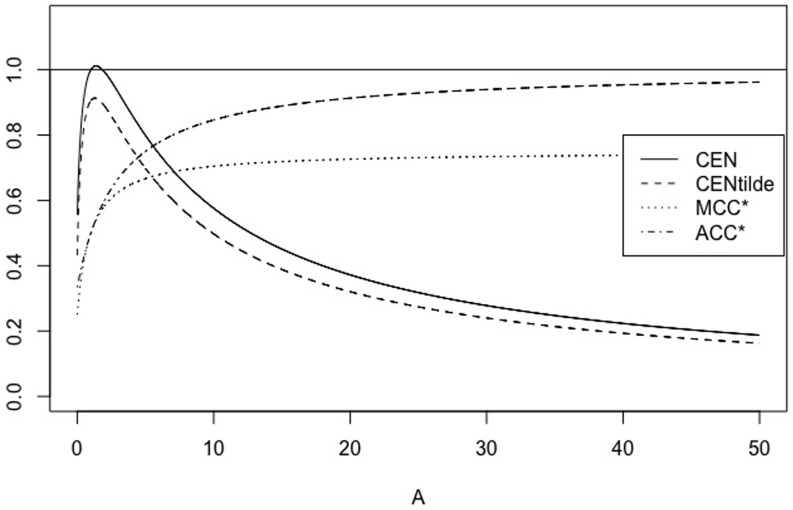
Family ZA.CEN, MCEN, MCC* and ACC* as function of A > 0 for N = 2.